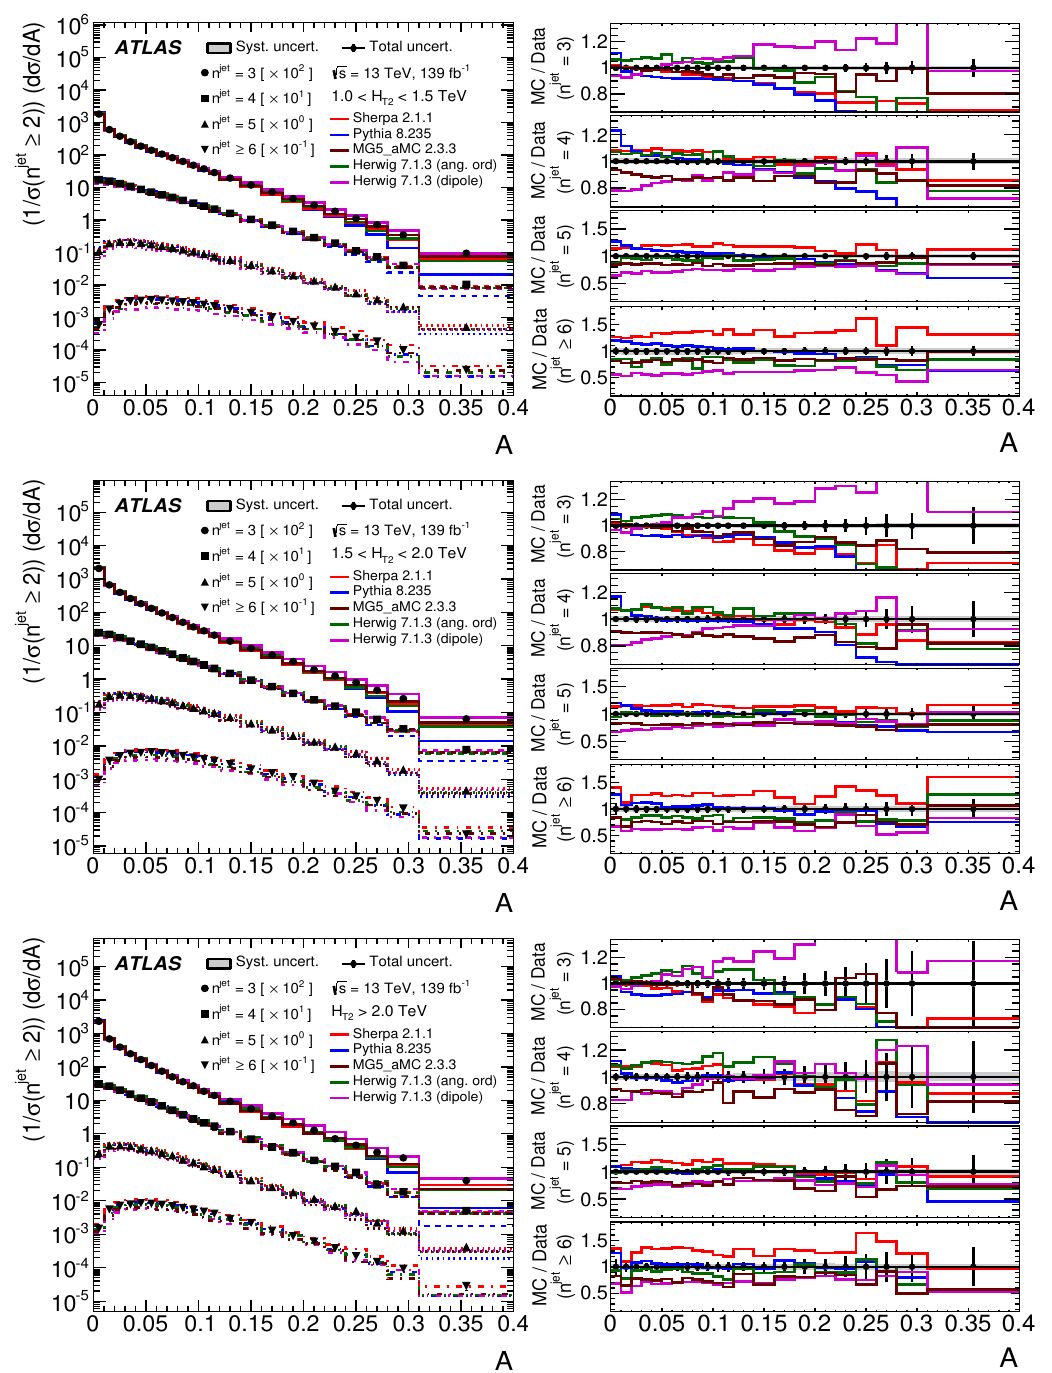
Figure 8 . Comparison between data and MC predictions as a function of the aplanarity A (see eq. 3.3) for different jet multiplicities and energy scales. For illustration purposes, the correspond- ing differential cross section for each jet multiplicity is multiplied by 10 2 ( n jet = 3), 10 1 ( n jet = 4), 10 0 ( n jet = 5), 10 − 1 ( n jet ≥ 6). The right panels show the ratios between the MC and the data distributions. The error bars show the total uncertainty (statistical and systematic added in quadrature) and the grey bands in the right panels show the systematic